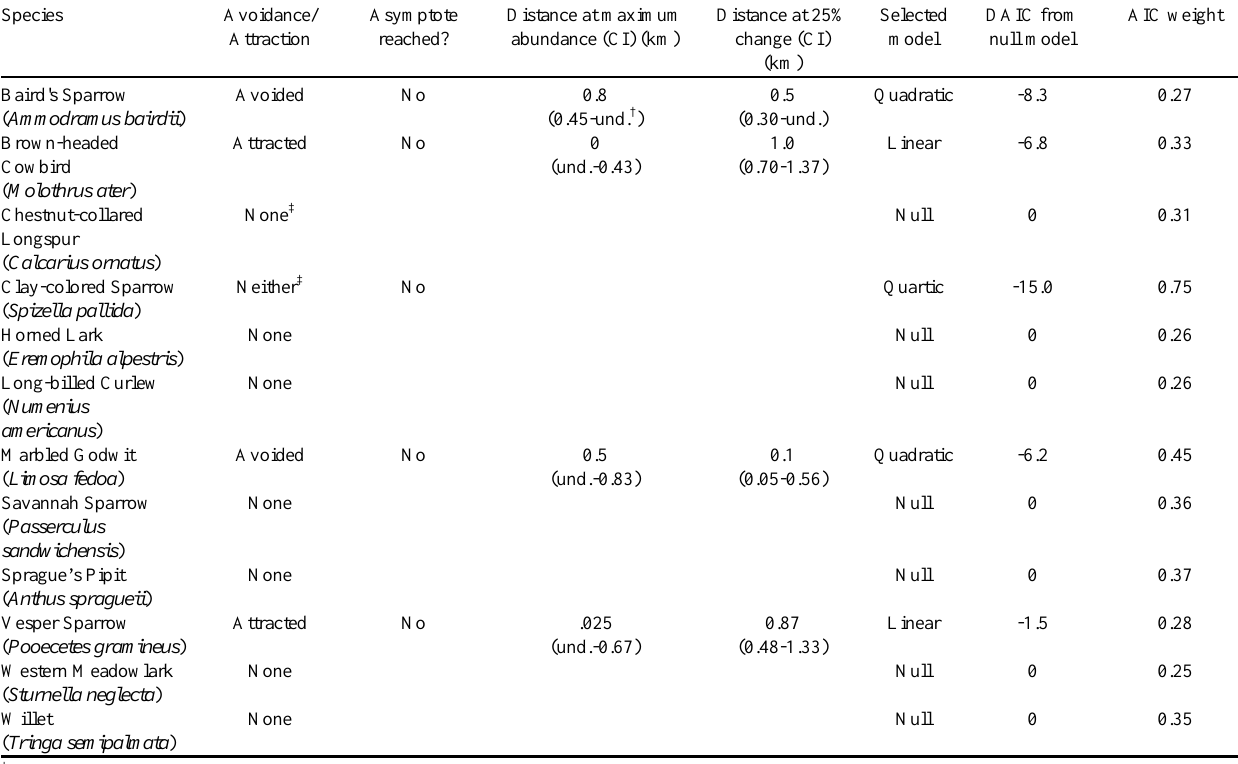
Table 3 . Effect of distance to roads on 12 bird species in Alberta, Canada, 2000-2002.